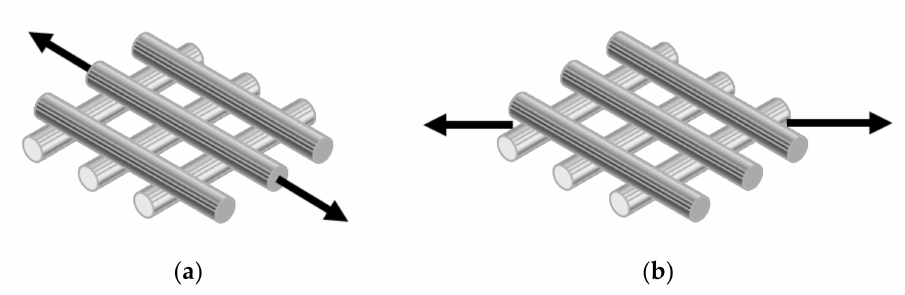
Figure A2. Illustration of tensile testing with tension in ( a ) axial direction and ( b ) diagonal